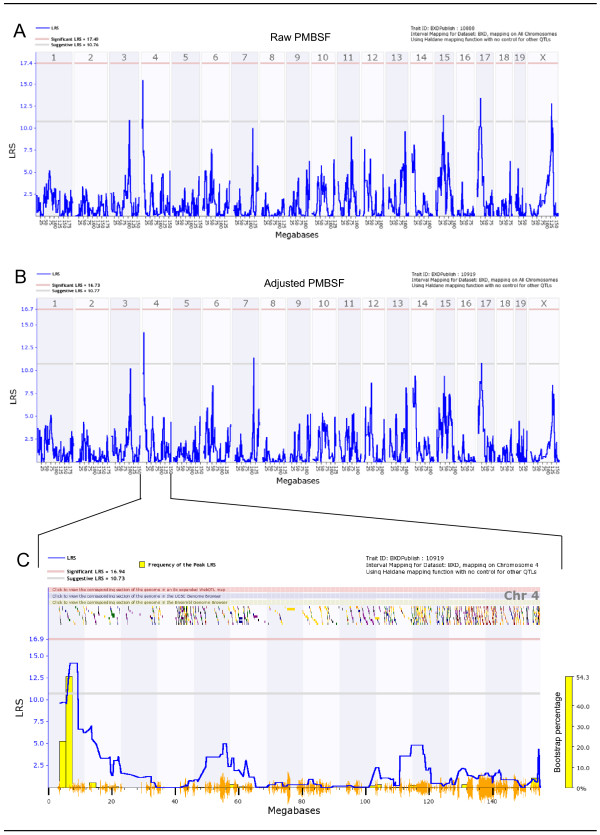
Genome-wide total PMBSF raw and adjusted linkage maps and chromosome 4 interval map. (A) Genome-wide linkage map of raw PMBSF area shows two suggestive QTLs on chromosomes 4 and 17. (B) Total PMBSF area linkage map after adjustment for brain weight shows a suggestive QTL on chromosome 4. Chromosome 17 linkage is not observed here. (C) Chromosome 4 interval map of adjusted total PMBSF area. Genes spanning the interval of 5.5 to 9.0 Mb on chromosome 4 were examined. Lower gray horizontal line: suggestive LRS genome-wide threshold at p ≤ 0.63. Upper red horizontal line: significant LRS genome-wide threshold at p ≤ 0.05. Yellow histogram: frequency of peak LRS (bootstrap analysis). Orange seismograph marks indicate SNP density.